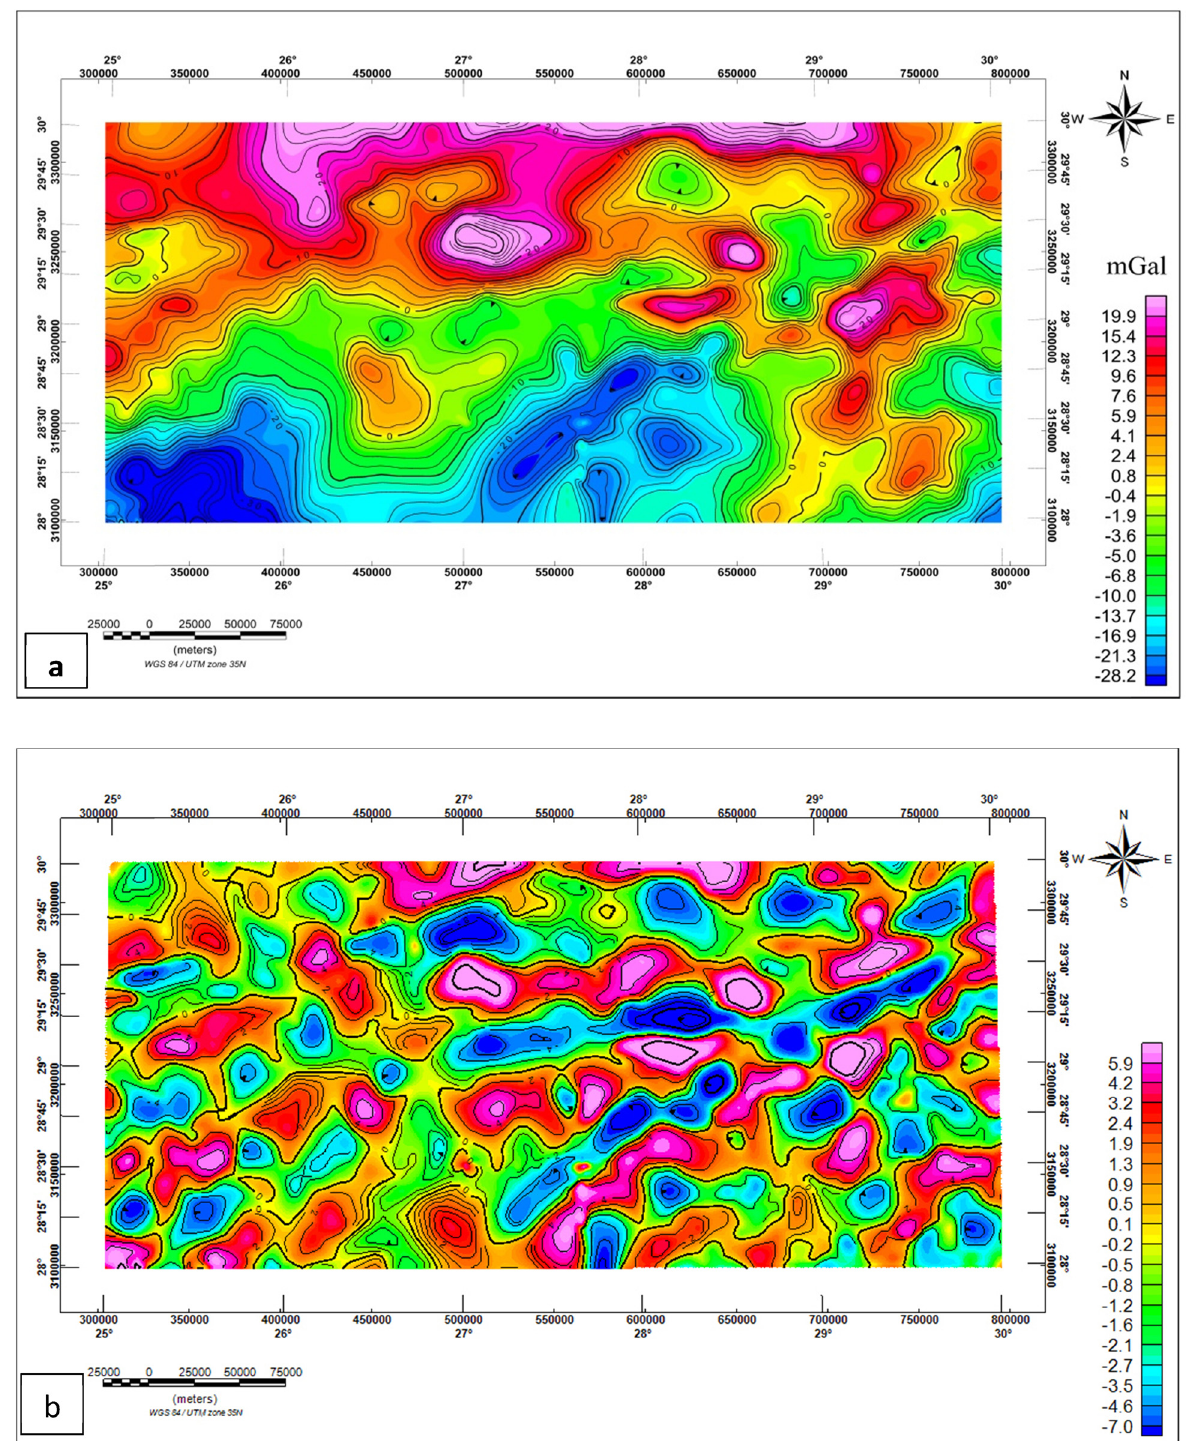
Figure 6: ( a ) Residual and ( b ) high pass fi lter of the gravity